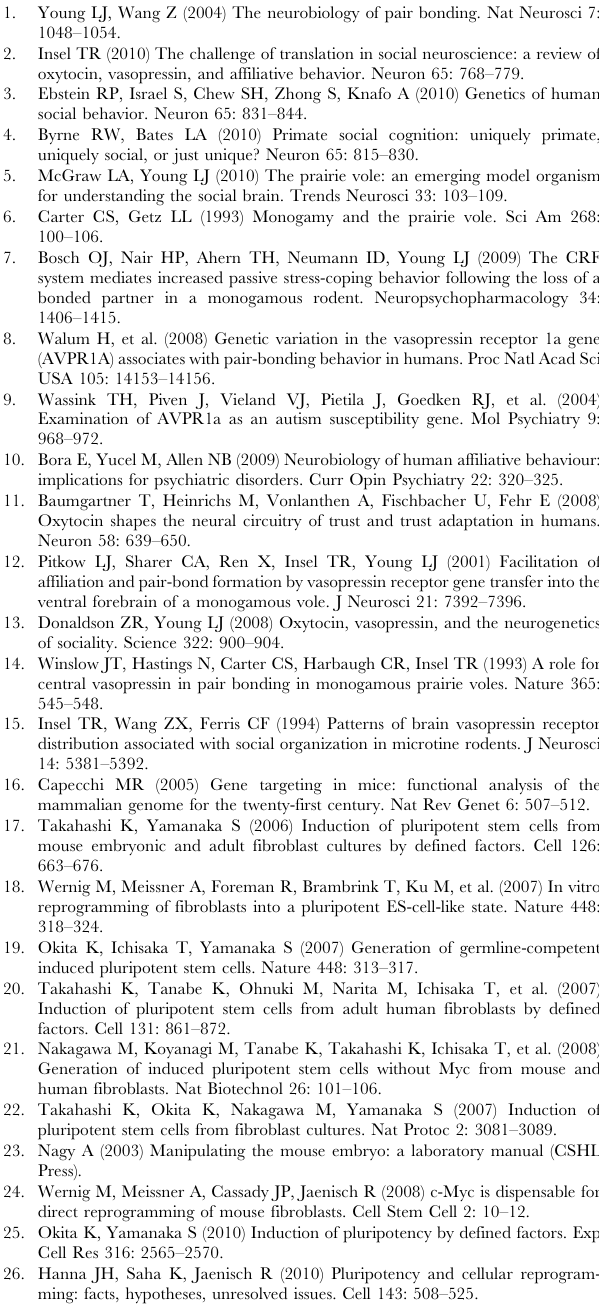
Table S3 Sequence of primers used for